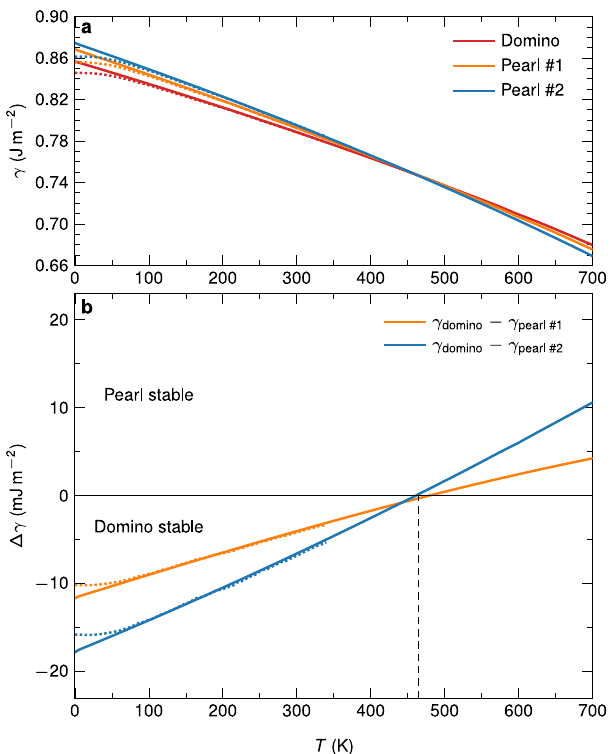
Fig. 5 Free energy calculation with the EAM potential using the quasi- harmonic approximation. a Plot of the GB free energies γ for the three low- energy structures we discovered. The dashed lines indicate an approximation with quantum-mechanical effects, the solid lines represent a purely classical approximation. The classical approximation yields equivalent results above 100 K. b The free energy differences show that the domino phase is stable below ~460 K, while pearl #2 is stable above that temperature.